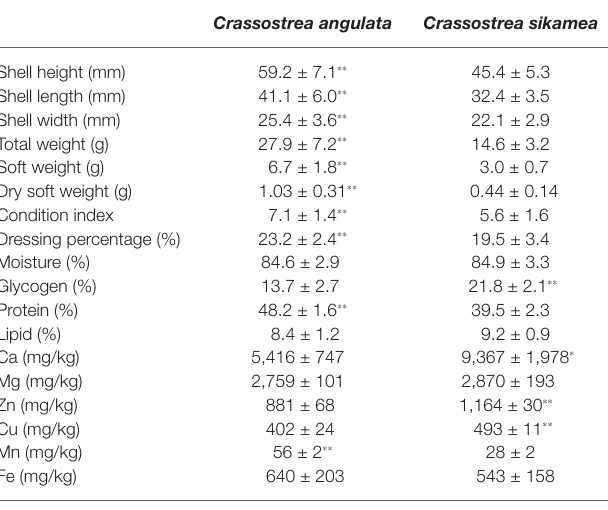
TABLE 1 | Production performance proximate composition and mineral content of Crassostrea sikamea and Crassostrea angulata in Xiangshan